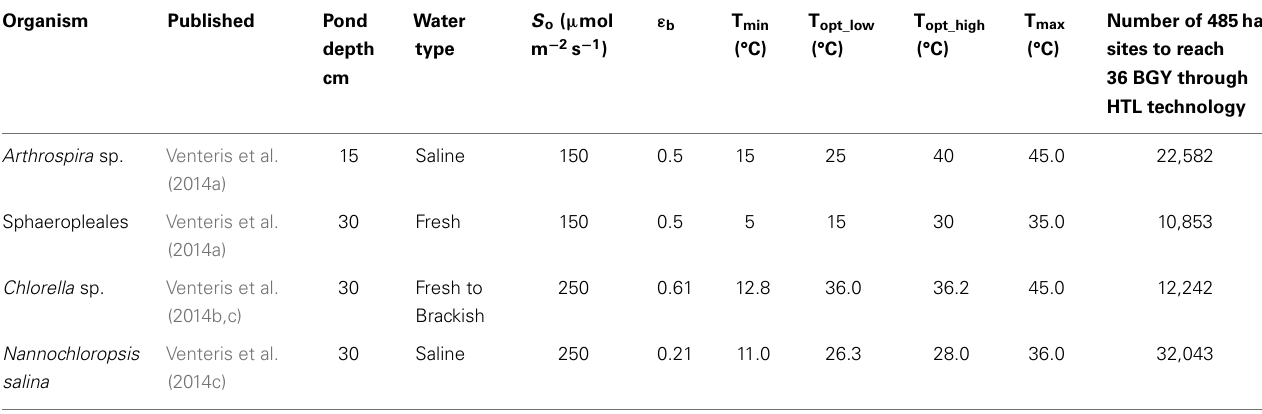
Table 1 | Summary of growth model parameters used with theWigmosta et al. (2011) growth model, and the initial publication of appearance for the four strains used in this study